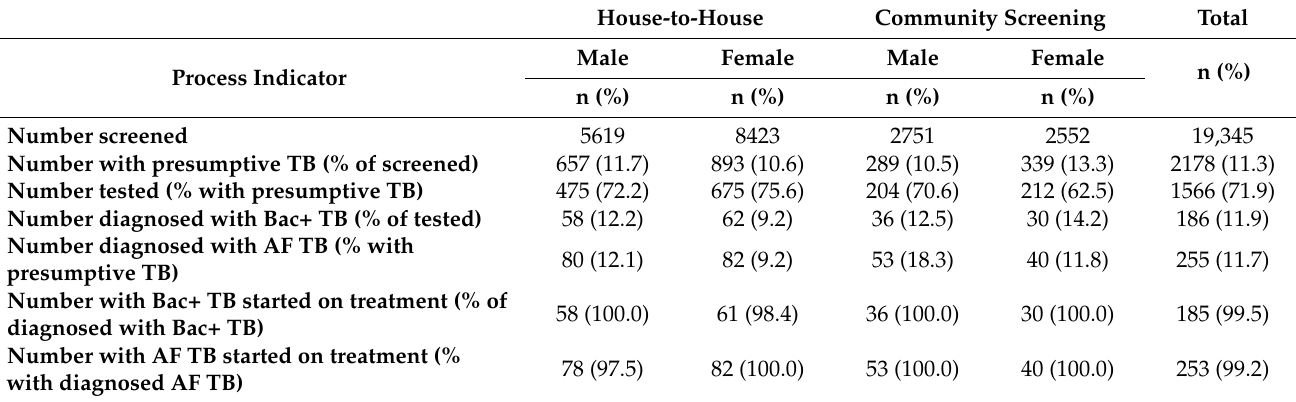
Table 5. Outcome of active case-finding activities in Punhana block. House-to-House Community Screening